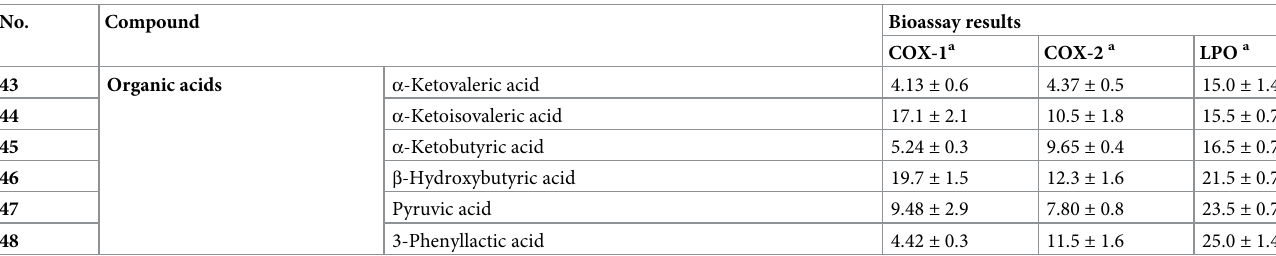
tions from sea lamprey skin extract constituted 36.1% saturated, 46.6%